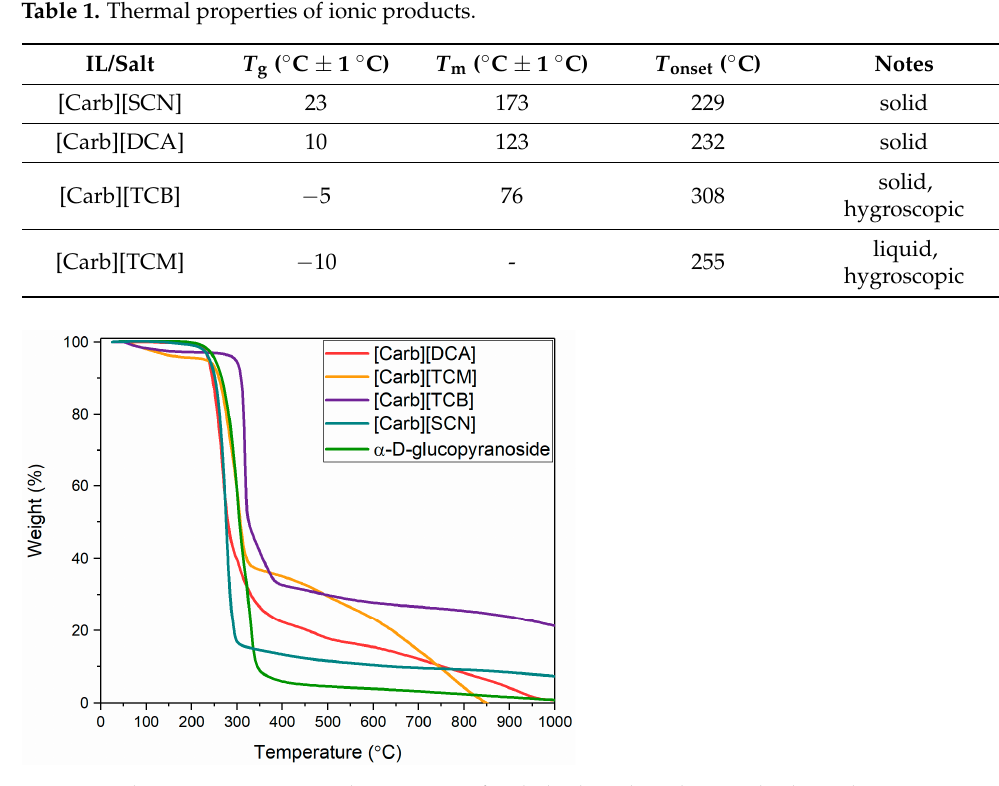
Figure 2. Thermogravimetric analysis curves of carbohydrate-based ILs and salts with cyano anions.